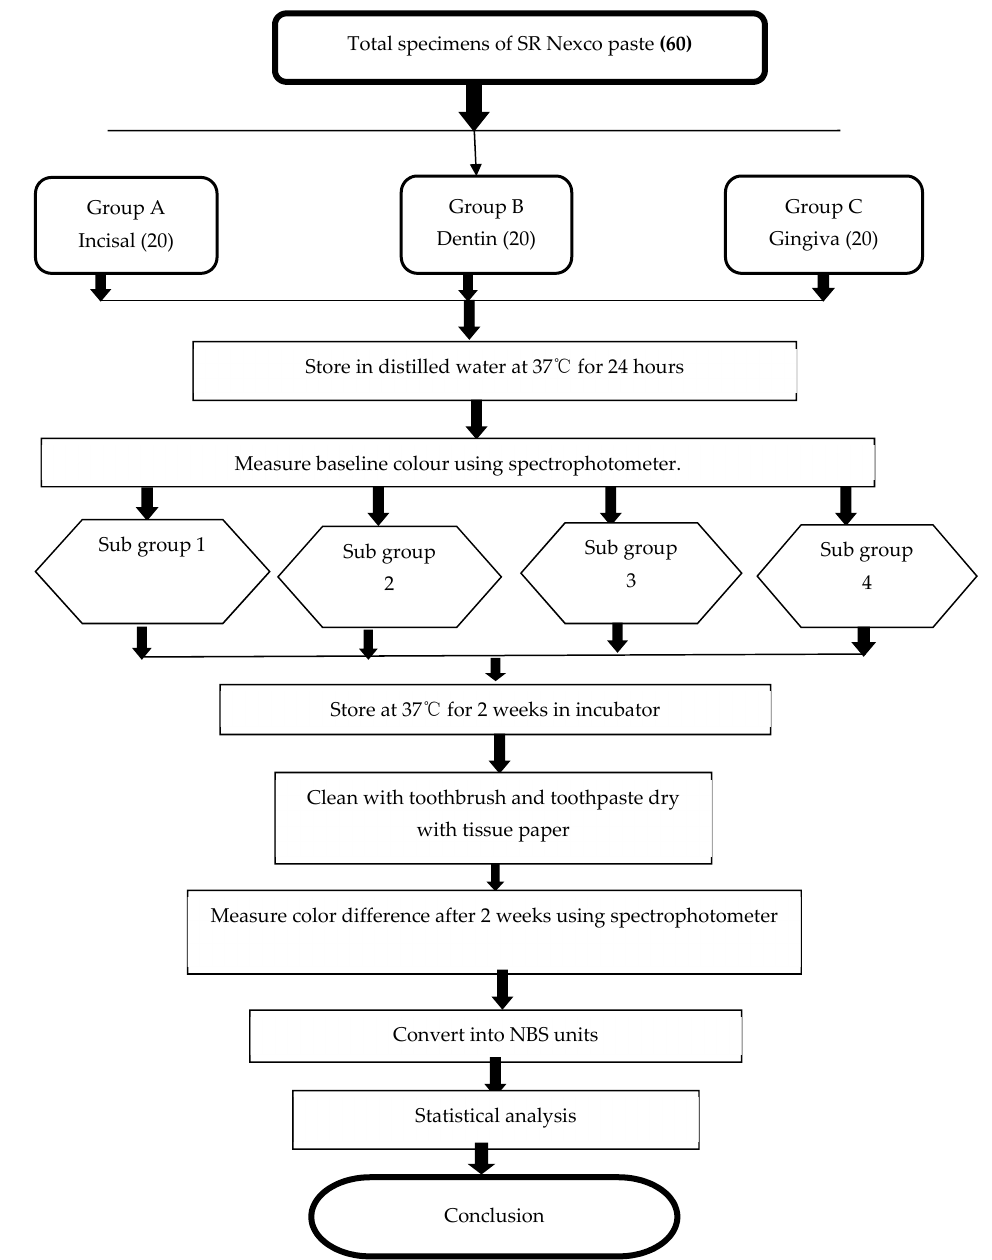
Figure 6. Schematic representation of the study.